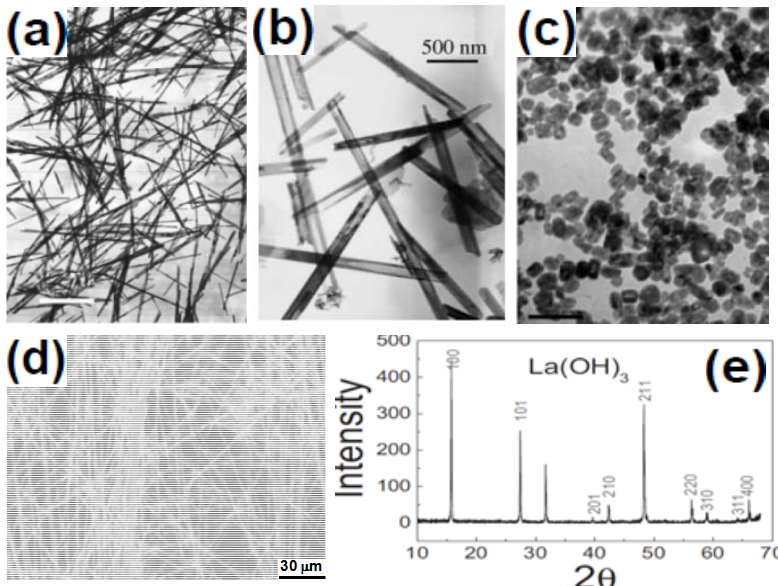
Figure 3. TEM images of ( a ) La(OH) 3 nanowires. Reproduced from [47]. Copyright 2002, John Wiley and Sons; ( b ) Y 2 O 3 nanotubes. Reproduced from [48]. Copyright 2003, John Wiley and Sons; ( c ) LaF 3 nanoparticles. Reproduced from [49]. Copyright 2003, John Wiley and Sons; ( d ) La(OH) 3 nanobelt; ( e ) a typical XRD pattern of the as-synthesized La(OH) 3 . Reproduced from [50]. Copyright 2007, John Wiley and Sons.